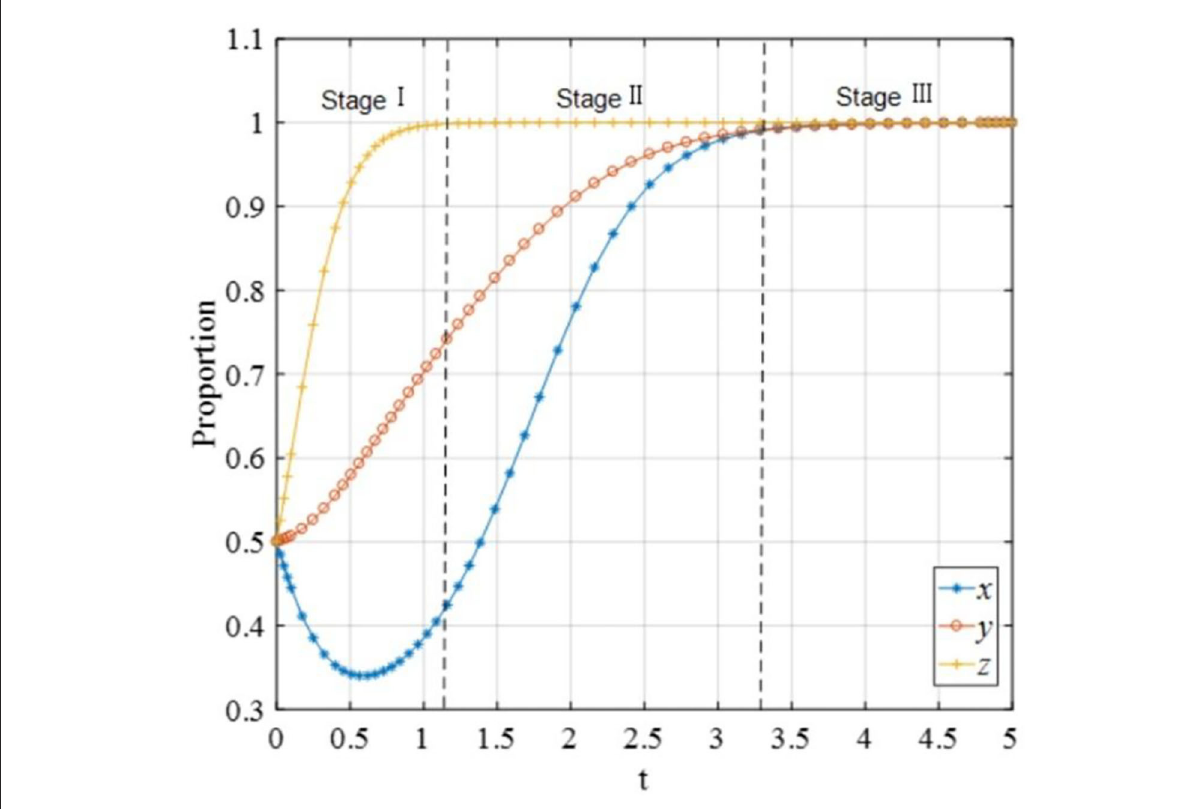
FIGURE16 The evolutionary process with the co-governance